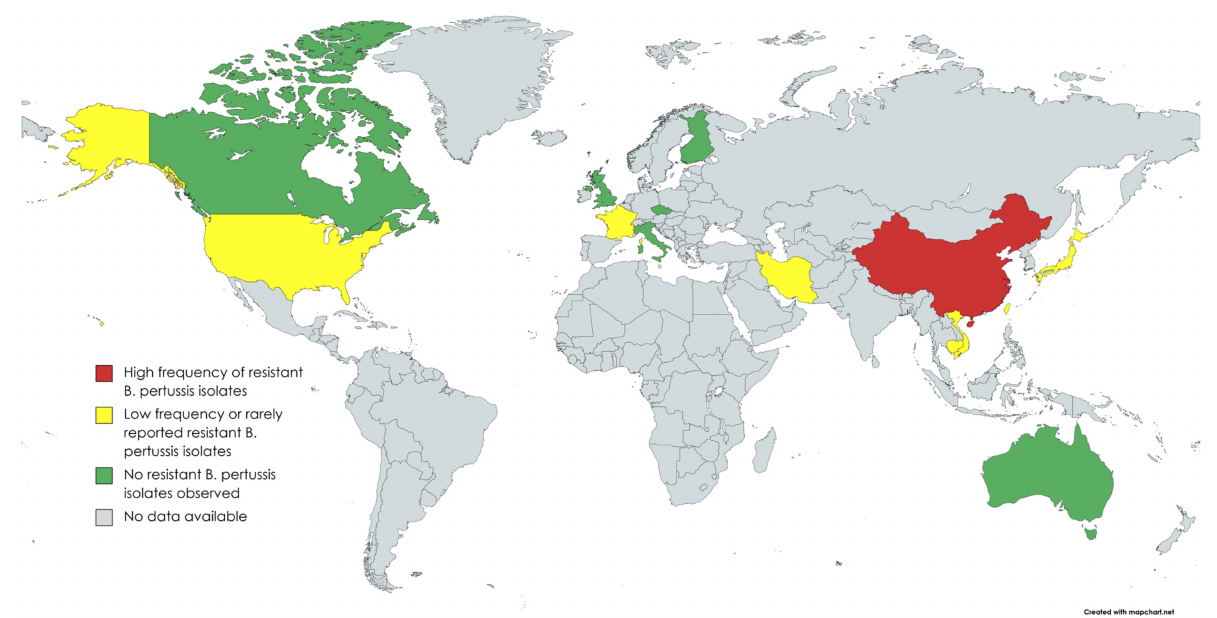
Figure 1. Countries where B. pertussis antimicrobial susceptibility studies have been performed (created with